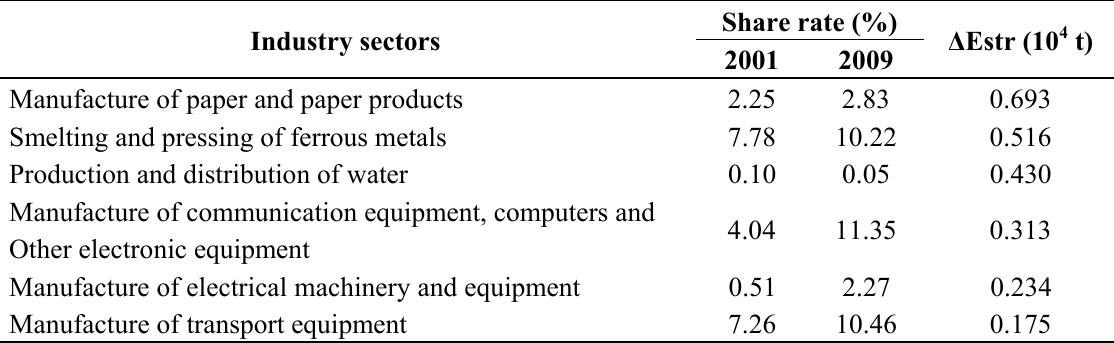
of COD changes between 2001 and